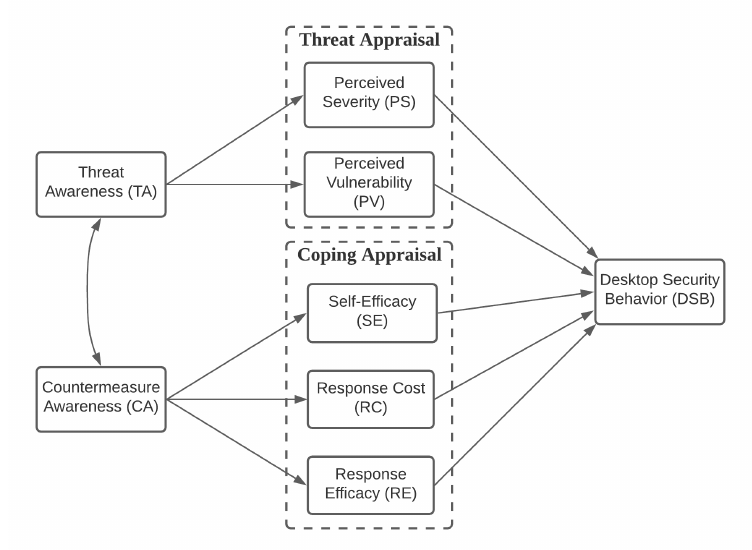
Figure 1. Protection motivation theory applied to desktop security behavior. Redrawn from Hanus and Wu